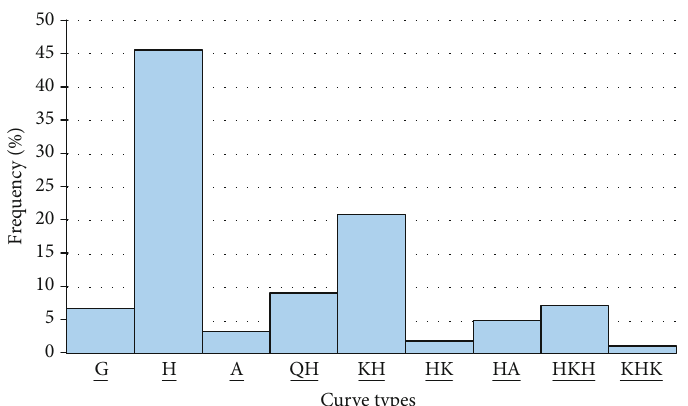
Figure 16: Histogram of the curve types in the Colomine area.